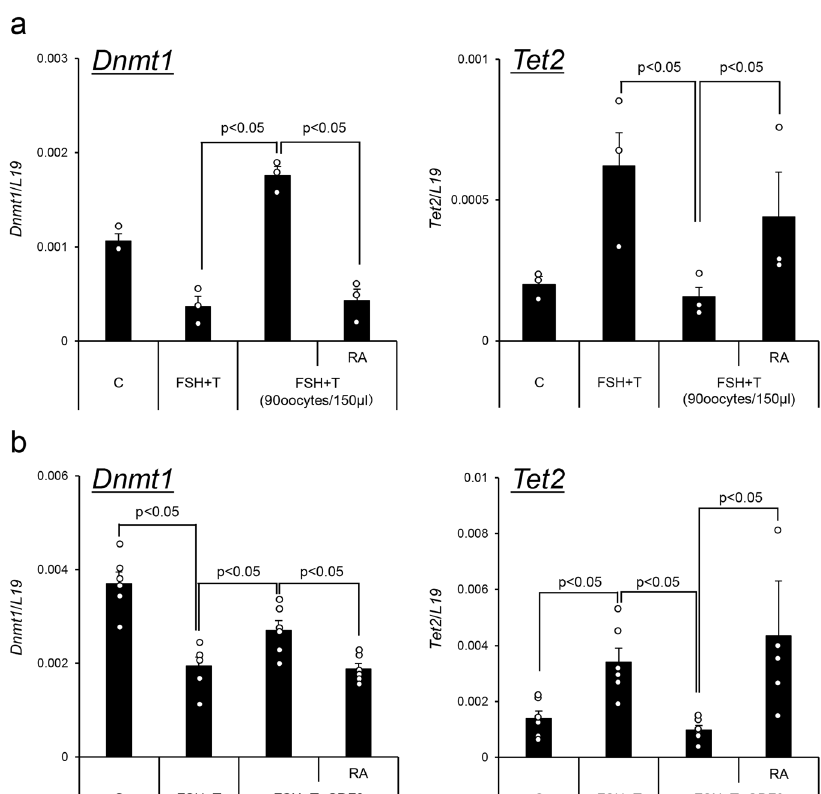
Fig. 6 Oocytes impact the expression of Dnmt1 and Tet2 in granulosa cells and cumulus cells. a The effect of coculture with denuded oocytes on the expression of Dnmt1 and Tet2 in granulosa cells. Granulosa cells were collected from ovaries of 3-week-old mice after treatment with eCG for 6 h and were cultured in medium supplemented with FSH plus T in the presence of 1% FBS. GV-stage oocytes were collected from COCs. None or 90 GV-stage oocytes/ 150 μ l were cocultured with granulosa cells. Values are represented as the mean ± SEM ( n = 3 biological replicates). Levels of mRNA were normalized to that of L19 . FSH + T. Granulosa cells were cultured with FSH (100 ng/ml) and testosterone (10 ng/ml) for 48 h. RA, RA (1 μ M) was added to medium in which granulosa cells were cultured with 90 GV-stage oocytes. Signi fi cant differences were observed compared with cells treated with no oocytes or cells treated with 90 oocytes per 150 μ l of medium ( p < 0.05). b The effects of GDF9 on the expression of Dnmt1 and Tet2 in granulosa cells. Granulosa cells were collected from ovaries of 3-week-old mice after treatment with eCG for 6 h and were cultured in each treatment group in the presence of 1% (v/v) FBS. control (C); granulosa cells were cultured without any hormones for 48 h. FSH + T, granulosa cells were cultured with FSH (100 ng/ml) and testosterone (10 ng/ml) for 48 h. FSH + T + GDF9, granulosa cells were cultured with FSH + T and mouse recombinant GDF9 (100 ng/ml). FSH + T + GDF9 + RA, Granulosa cells were cultured with FSH + T + GDF9 and RA (1 μ M) for 48 h. Levels of mRNA were normalized to that of L19 . Values are represented as the mean ± SEM ( n = 6 biological replicates). Signi fi cant differences were observed among the treatment groups ( p < 0.05). replication sites and interacts with PCNA to ensure inheritance of unmethylated cytosine to 5-methylated cytosine 38 . When TET the existing DNA methylation patterns at S-phase and faithful factors are recruited to methylated regions of DNA during S-phase, daughter cell identity 37 . During S-phase, UHRF1 and DNMT3a TET converts 5-methylated cytosine to 5-hydroxymethylcytosine interact with DNMT1 on the N-terminal domain and convert via oxidative demethylation mechanisms, leading to demethylation COMMUNICATIONS BIOLOGY| (2021) 4:1334